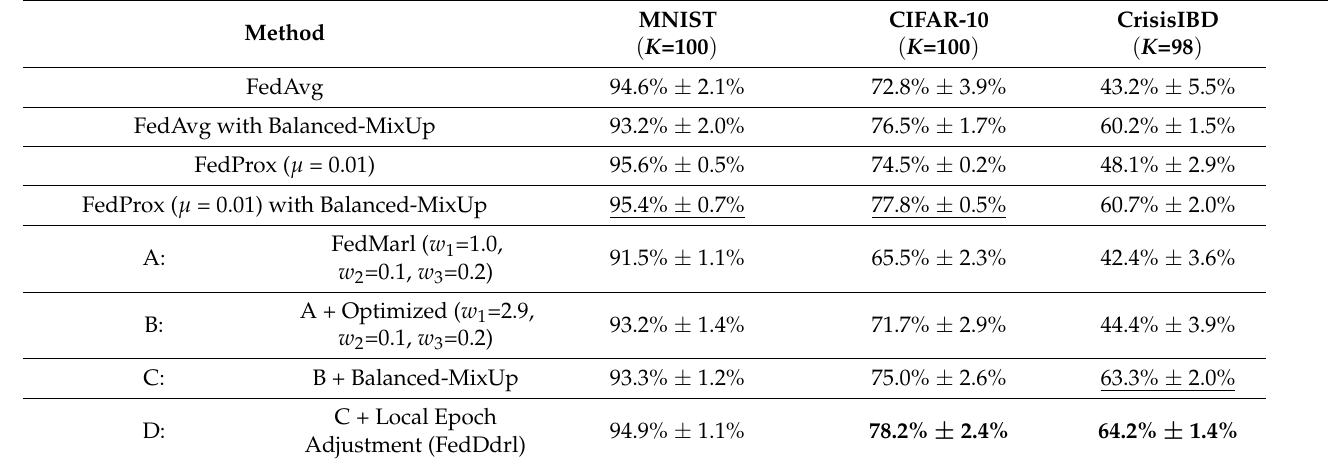
Table 4. Model accuracy for each FL setting. Bolded indicates the best score, while underlined indicates the second-best